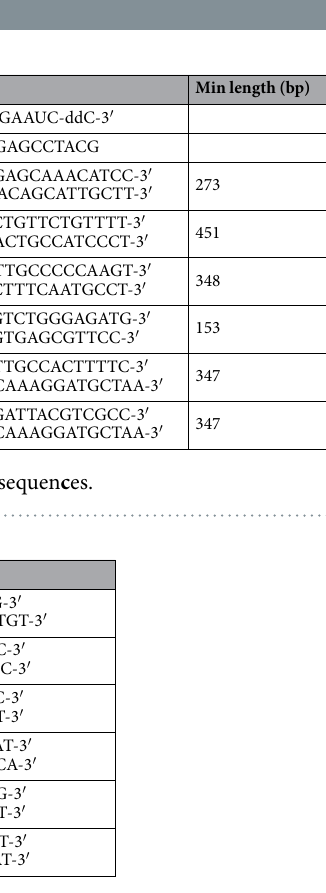
Table 3. qPCR primer sequences.